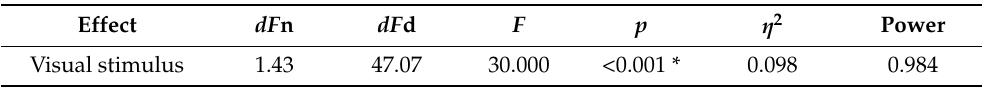
Table 7. The one-way ANOVA output table with effect size reported with η 2 and the results of the power analysis added to the rightmost column.